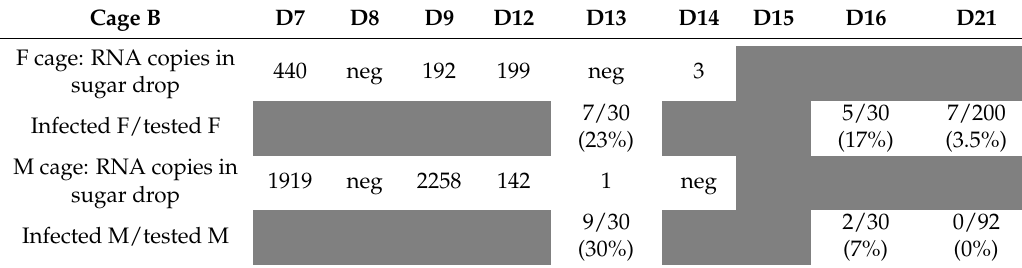
F cage: RNA copies